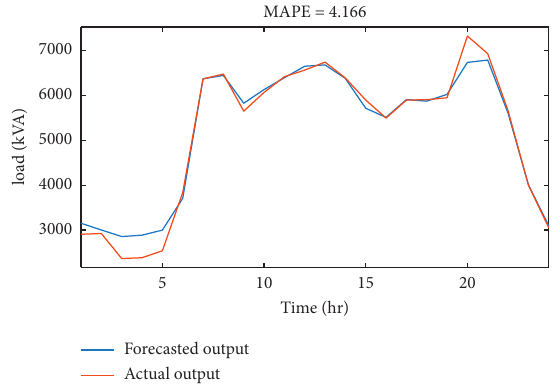
Figure 24: The Fuzzy-PSO prediction of weekday load.